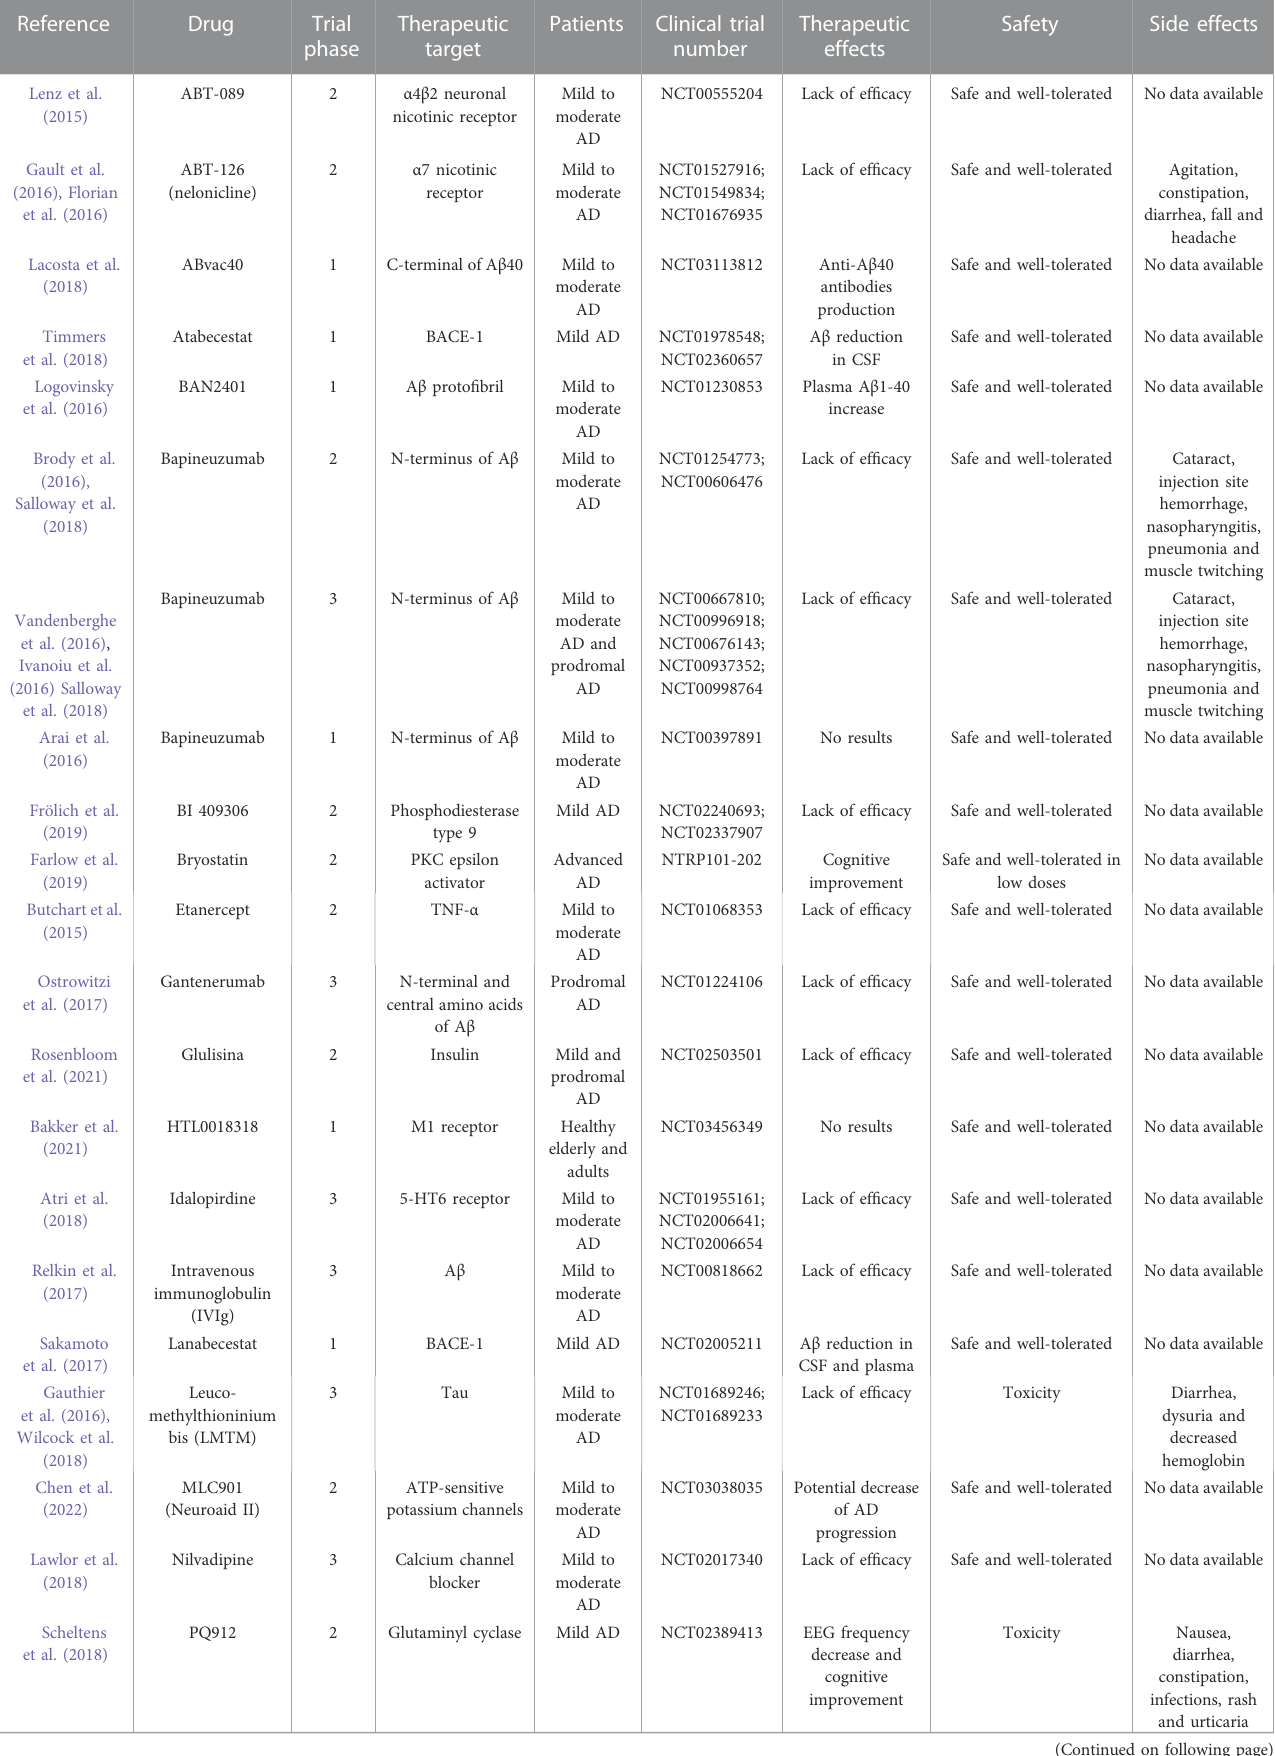
TABLE 1 Information of clinical trials